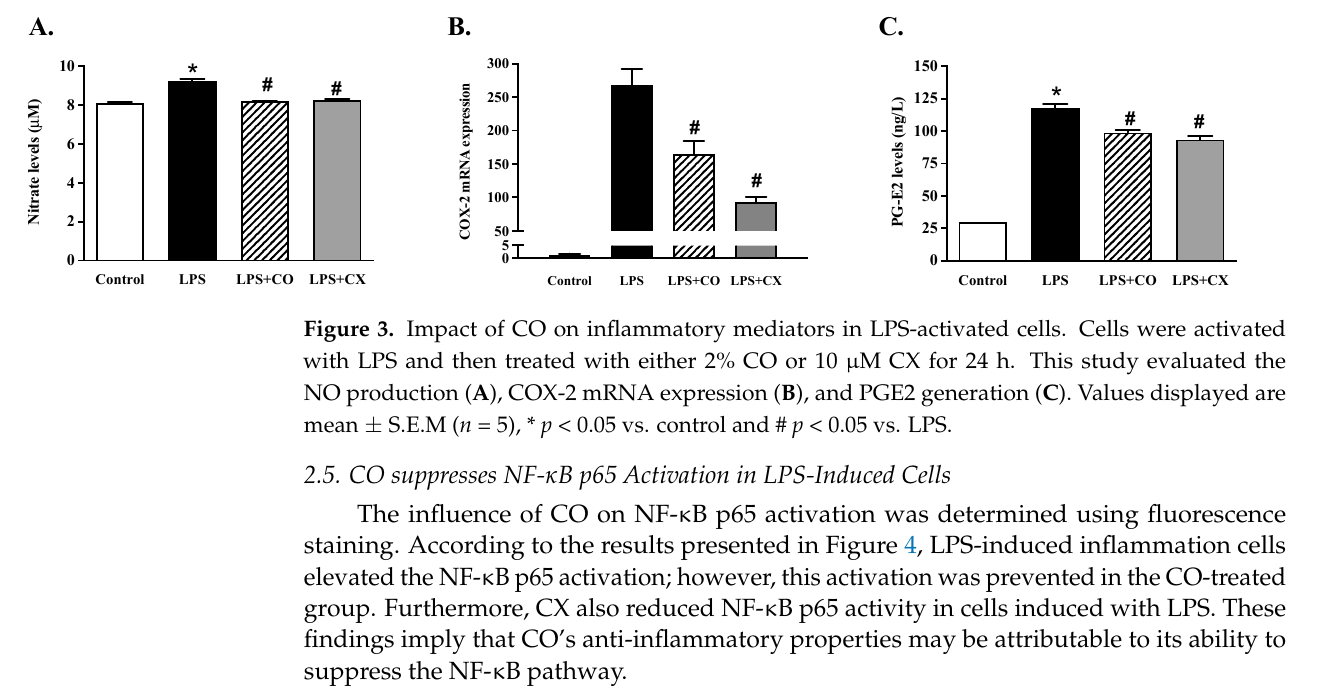
5 of 13 Figure 2. The effects of CO on the gene expression of proinflammatory cytokines. LPS-activated RAW 264.7 cells were incubated with CO for 24 h and the inflammatory cytokine gene expression was measured. During the 24 h of experiments, cells were given either 2% CO or 10 µM CX with or without LPS. qPCR was used for the gene expression of IL − 6, IL − 1 β , and TNF −α ( A – C ). Values dis- played are mean ± S.E.M ( n = 5), * p < 0.05 vs. control and # p < 0.05 vs. LPS. 2.4. CO Reduces Inflammatory Mediators in LPS − Induced Cells To determine the effects of CO on the production of inflammatory mediators, the mediator levels were determined using Griess, qPCR, and an ELISA assay, respectively. The results show the generation of nitric oxide (NO) (Figure 3A). Cells exposed to LPS for 24 h increased their NO generation compared to the control group. In addition, CO and CX reduced NO levels in LPS − stimulated cells compared to the cells stimulated by LPS